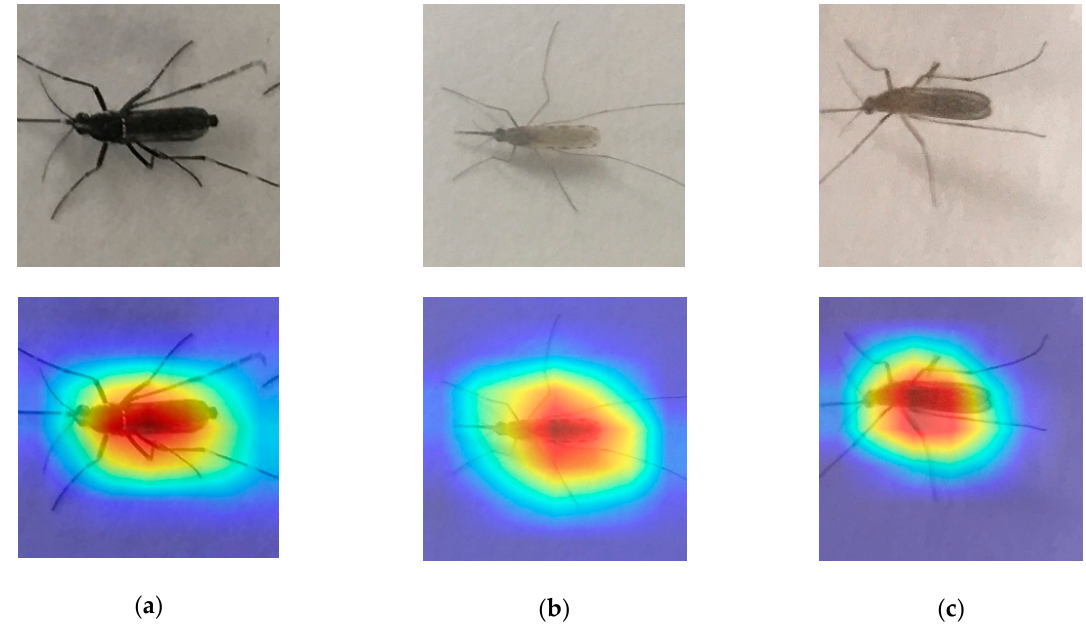
Figure 7. Example results of the confusion matrices.